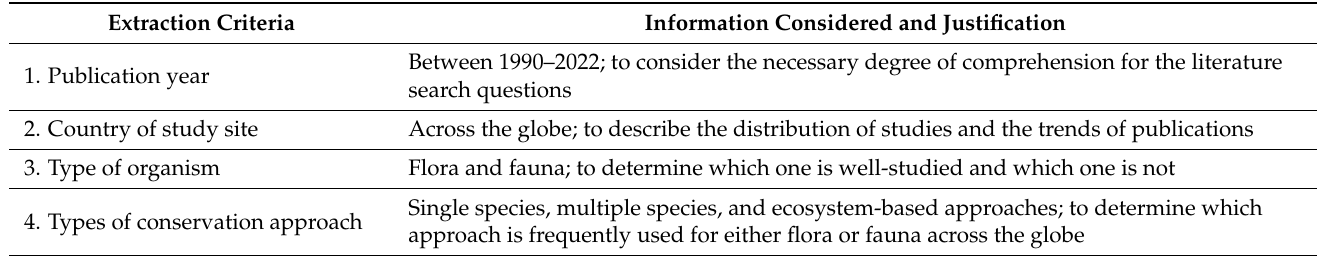
Figure 1. The flow diagram for database search of peer-reviewed original and review articles used for the present systematic literature review. Table 2. The criteria used for the extraction of information from the selected peer-reviewed original and review